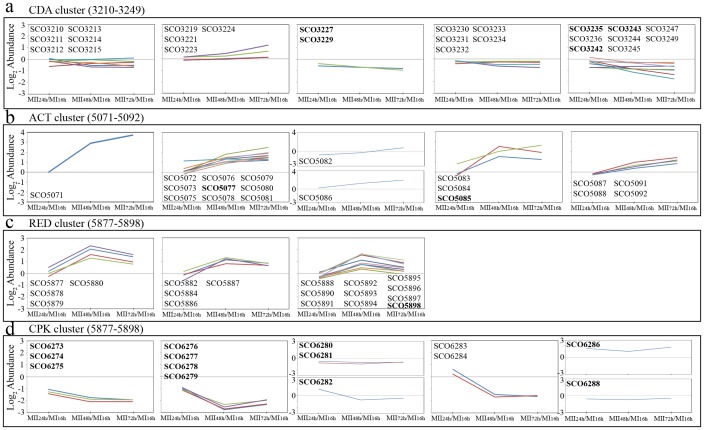
Quantitative transcriptomic data of genes involved in the synthesis of the most important secondary metabolites produced by S. coelicolor.(a) CDA cluster, genes SCO3210–SCO3249. (b) ACT cluster, genes SCO5071–SCO5092. (c) RED cluster, genes SCO5877–5898. (d) Cpk cluster, genes SCO6273–SCO6288. Genes were grouped into graphs according to their predicted operons. Genes included in the most reliable transcripts (Figure 3 and Table S1) are highlighted in bold. The remaining transcripts (Roman letters) also had good reproducibility in their abundance values, albeit not enough to meet the rigorous criteria used in this work (Table S2).